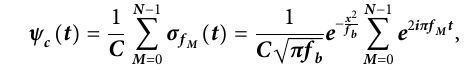
Frontiers in Physiology |